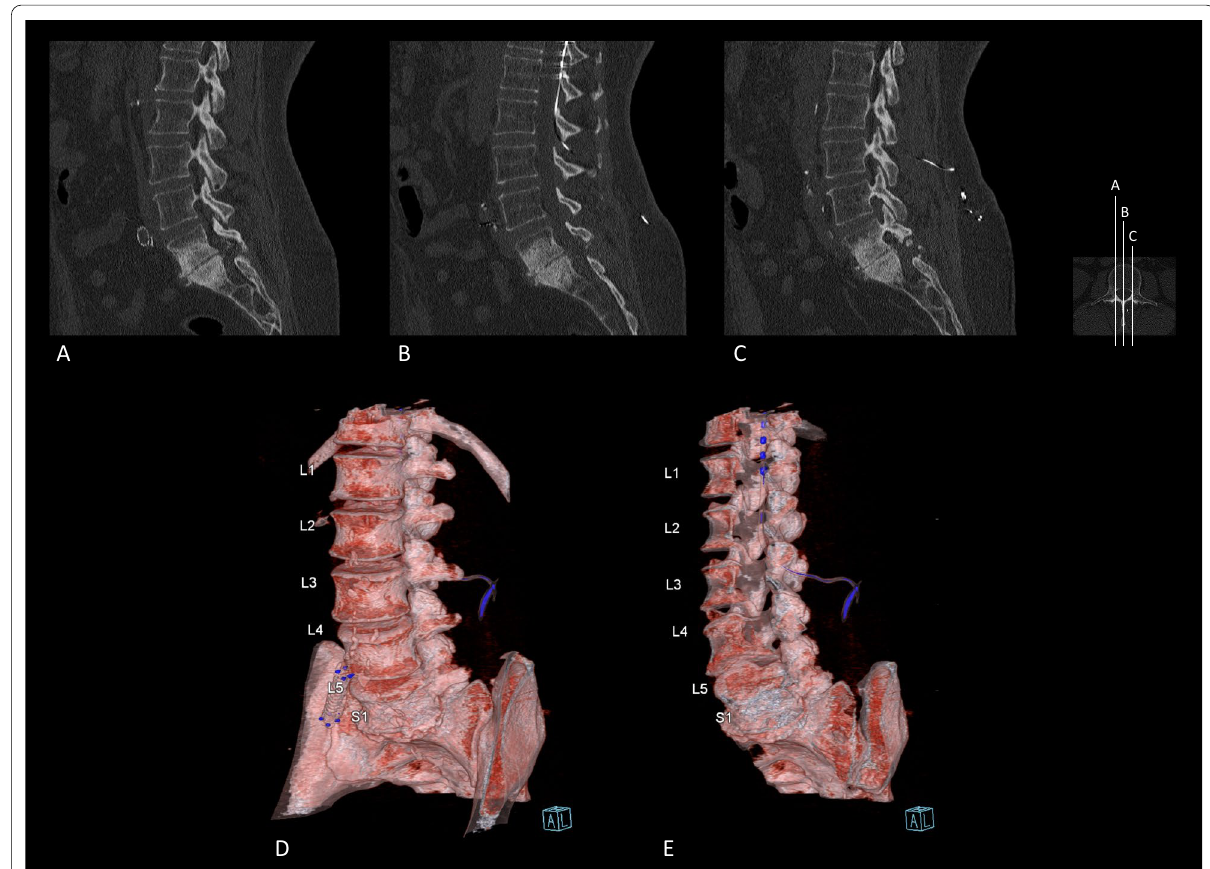
Fig. 3 Lumbar spine CT images in an FBSS patient with an implanted spinal cord stimulation system. A – C Sagittal reconstructions through the vertebral column as depicted by the axial miniature on the right-hand side. The spinal cord stimulation electrode can be observed lining the ventral aspect of the dorsal lamina on level Th12–L1. Sclerosis of L5 and S1 can be observed. Additionally, at level L5–S1, bilateral laminectomy has been carried out. D Three-dimensional reconstructions of the spine of the same FBSS patient. The connection of the extension cables to the internalized pulse generator can be appreciated in blue at level L3–L4. E Virtually dissected three-dimensional model of the spine of the same FBSS patient. The spinal cord stimulation electrode can be appreciated as multiple blue dots in the spinal canal. The extension cable can be followed into the paraspinal